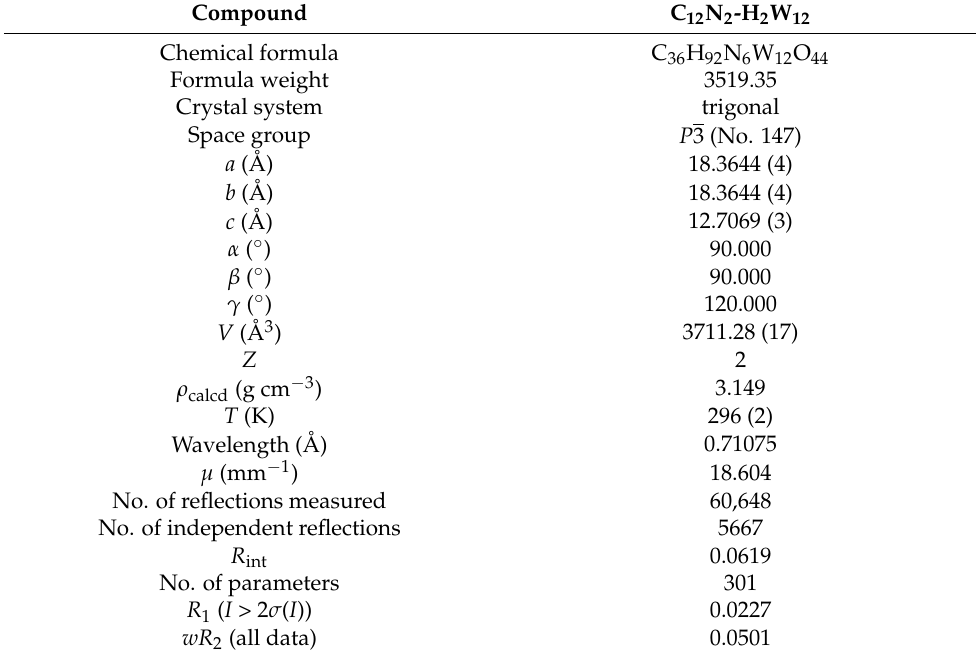
Table 1. Crystallographic